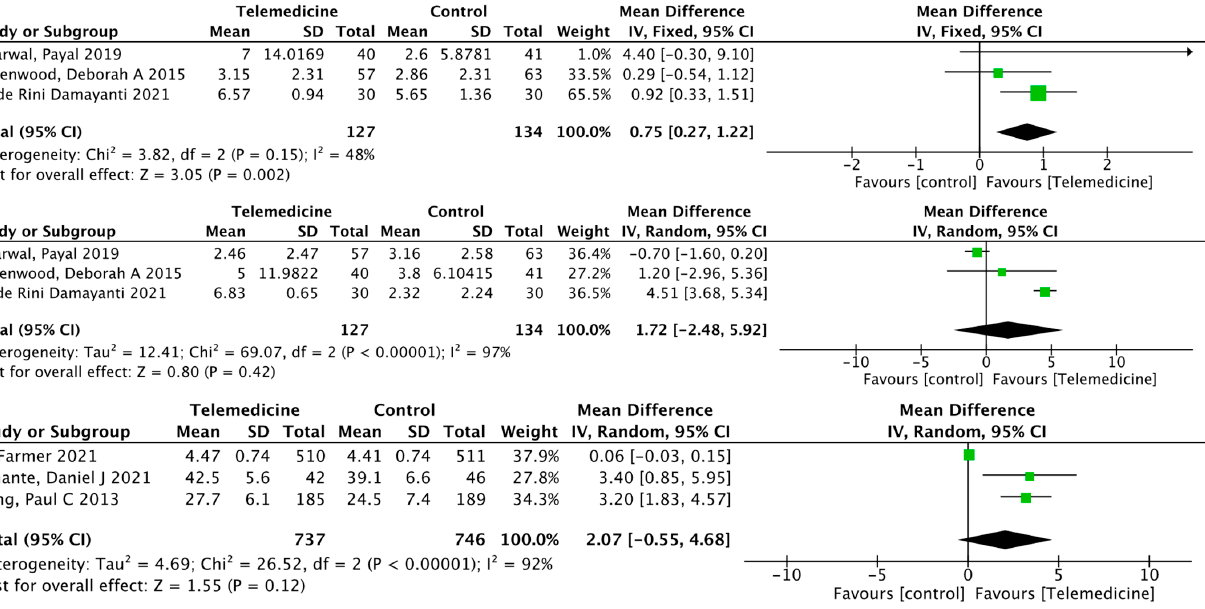
Figure 12. Mean difference in the changes in exercise, foot care, and satisfaction levels for telemed- icine and usual care interventions.